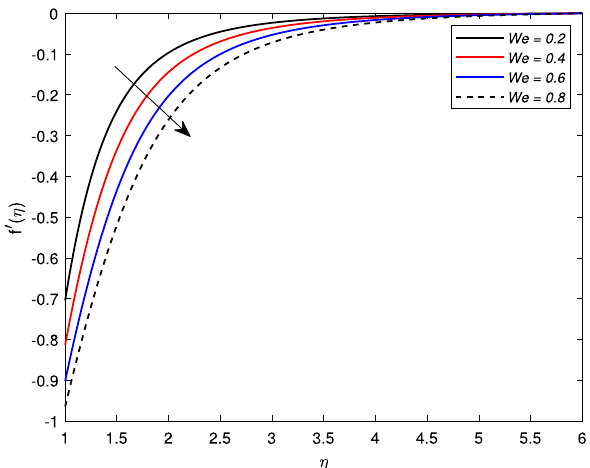
Figure 4. Impact of Weissenbert number We on f ′ (η) when A